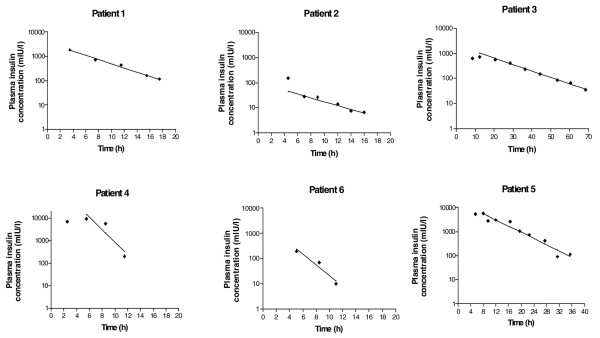
Plasma toxicokinetics of insulin in six severely insulin-poisoned patients.